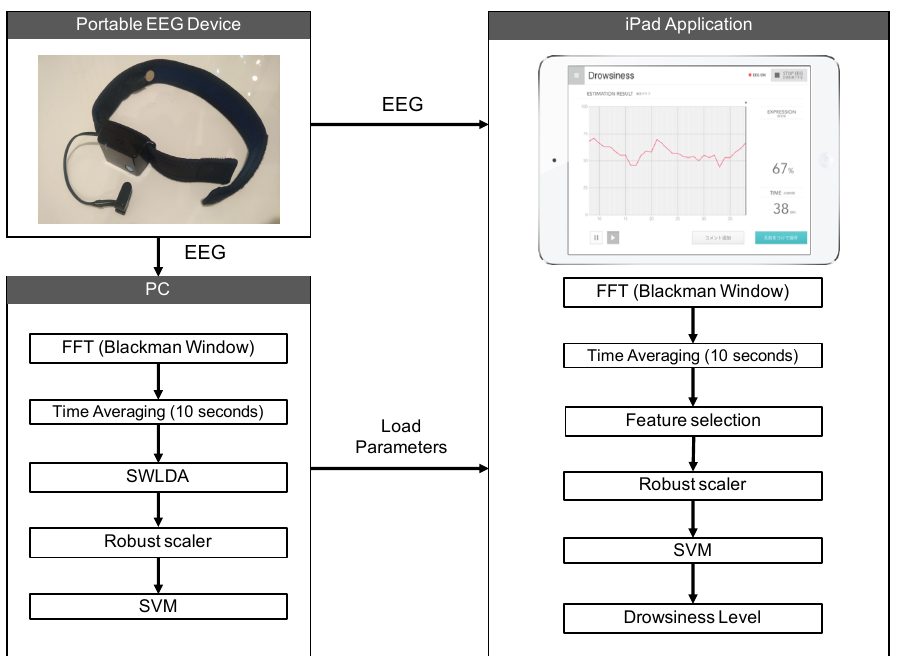
Figure 6. Flow diagram of the drowsiness detection system. Parameter learning was performed on a PC. The selected parameters were loaded onto the iPad and show the predicted drowsiness